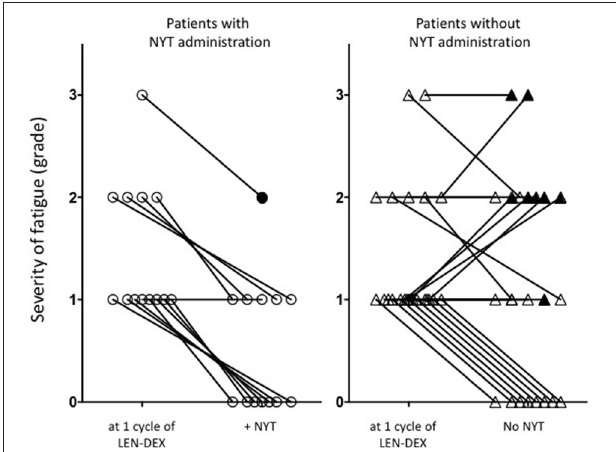
FIGURE 1 | Change of fatigue grade in patients treated with or without NYT. After 1 cycle-treatment of LEN-DEX, the severity of fatigue was graded, and then NYT was administered according to the patients’ requests. When the patients did not want NYT, LEN-DEX alone were continued. Assessment of the effectiveness of NYT for the severity of subjective fatigue and LEN-DEX discontinuation up to 6 months. (cid:13) , Patients with NYT administration; 1 , • Patients without NYT administration; and N , show LEN-DEX-discontinued patients within 6 months. For these 9 discontinued patients, severity of fatigue was evaluated at the last cycle of LEN-DEX administration.